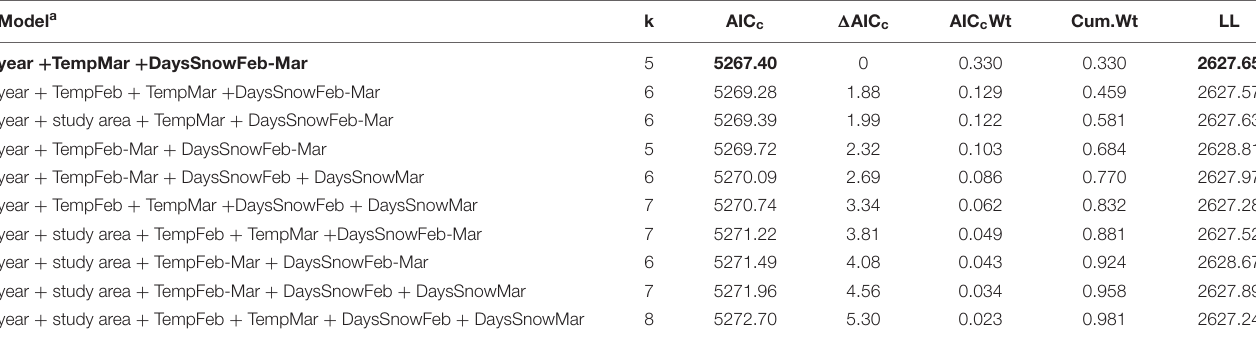
TABLE 2 | AIC c model selection rankings for hatching date (response variable) of Red-shouldered Hawks, in relation to year, temperature, snow cover, and study area. Model a